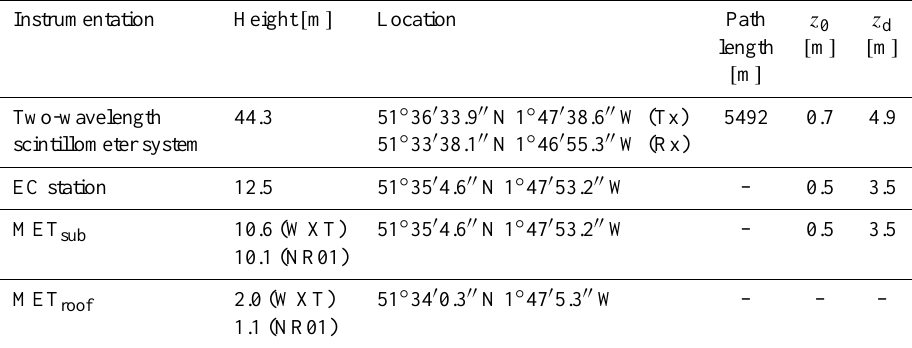
Table 1. The instrumental setup. For the scintillometers the mean height of the beam above the land surface ( z m ) is given (for the effective measurement height ( z ef ) see Table 2); for MET roof the heights above the roof surface are given. Roughness length, z 0 , and displacement height, z d , were not calculated for the rooftop site. Tx denotes transmitter, Rx